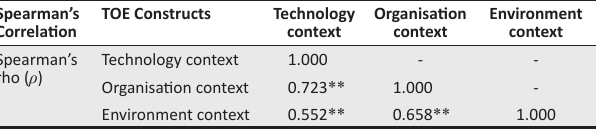
TABLE 2: Correlations of technology, organisation and environment theoretical framework.